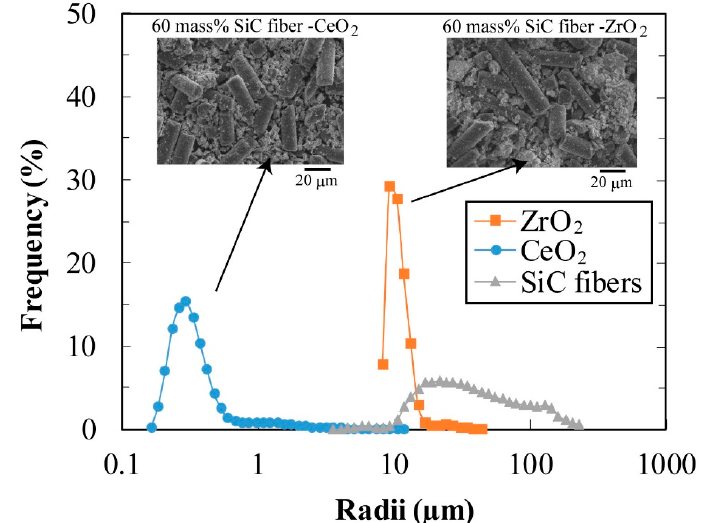
Figure 1. Particle size distributions of pure SiC fibers and CeO 2 and ZrO 2 powders with SEM images (×900, 15 kV) of their mixtures. The average sizes are 10.2 μ m for ZrO 2 , 0.3 μ m for CeO 2 , and 34.7 μ m for SiC fiber.